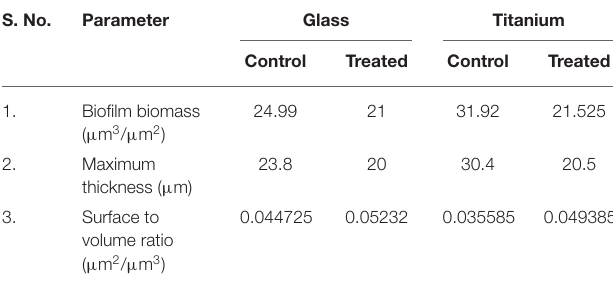
TABLE 2 | COMSTAT analysis of MRSE biofilm formed on glass and titanium surfaces in the absence and presence of UMB (at 500 µ g/ml). S.